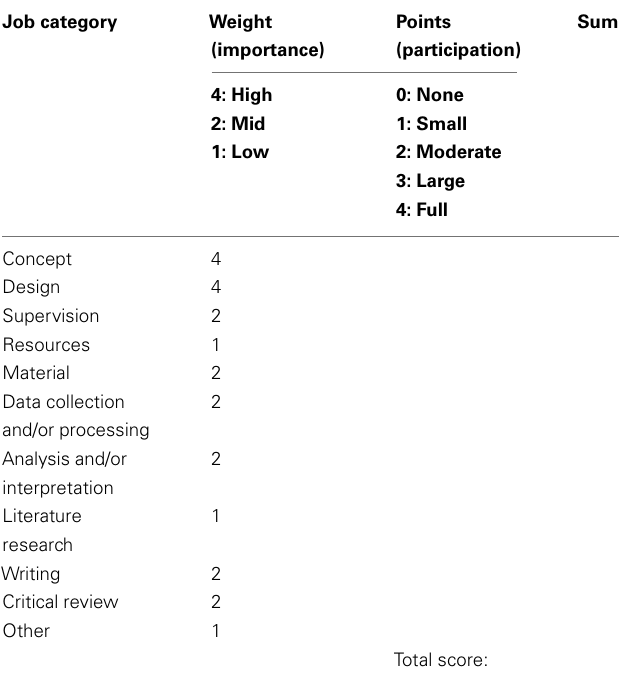
Table 2 | Example of a contribution form for deciding on individual